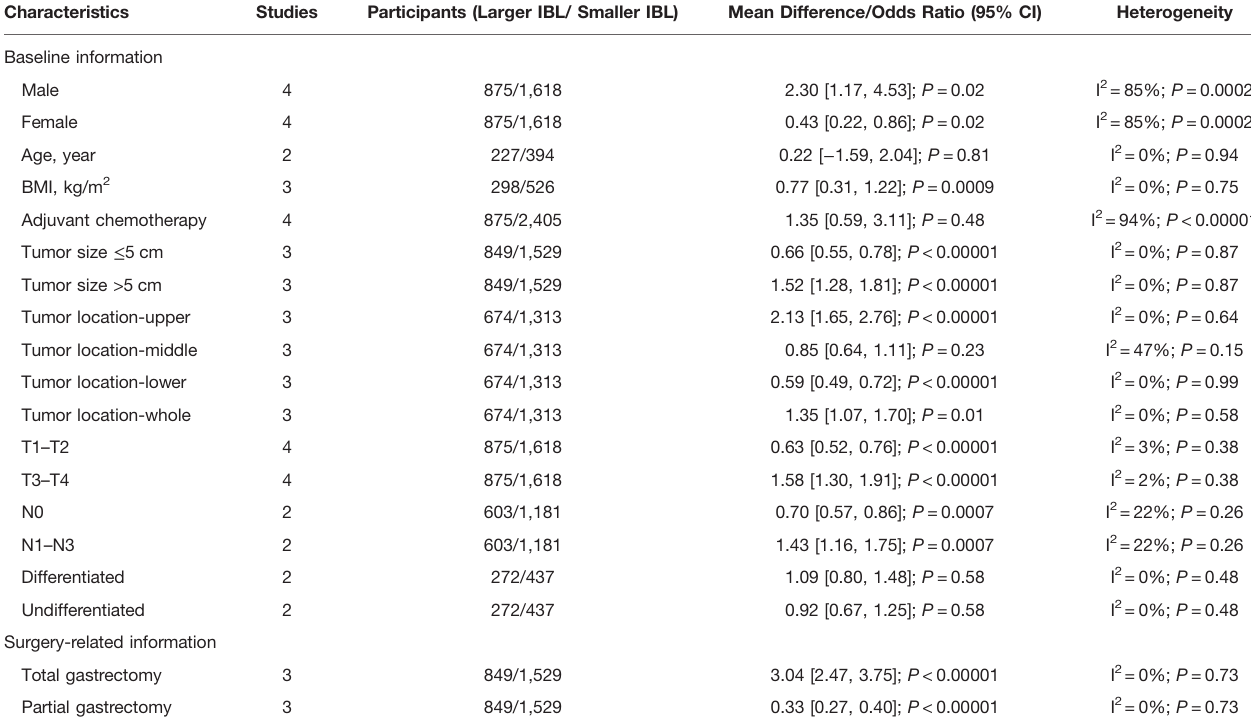
TABLE 2 | Summary of characteristics between larger IBL group and smaller IBL